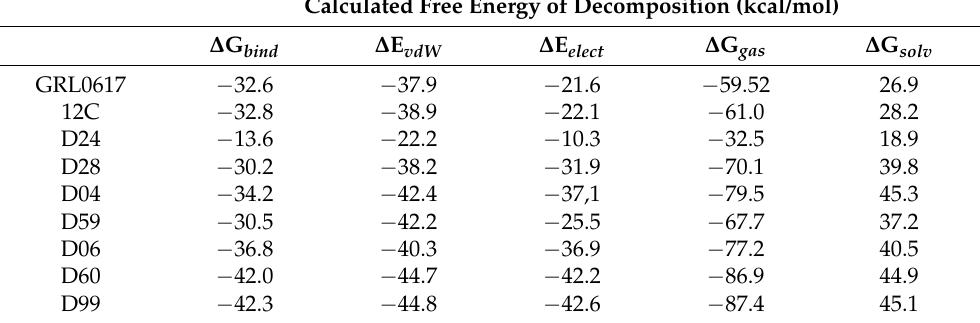
Table 1. Predicted binding free energies (kcal/mol) and individual energy terms calculated from molecular dynamics simulation following the MM-GBSA protocol for PLpro